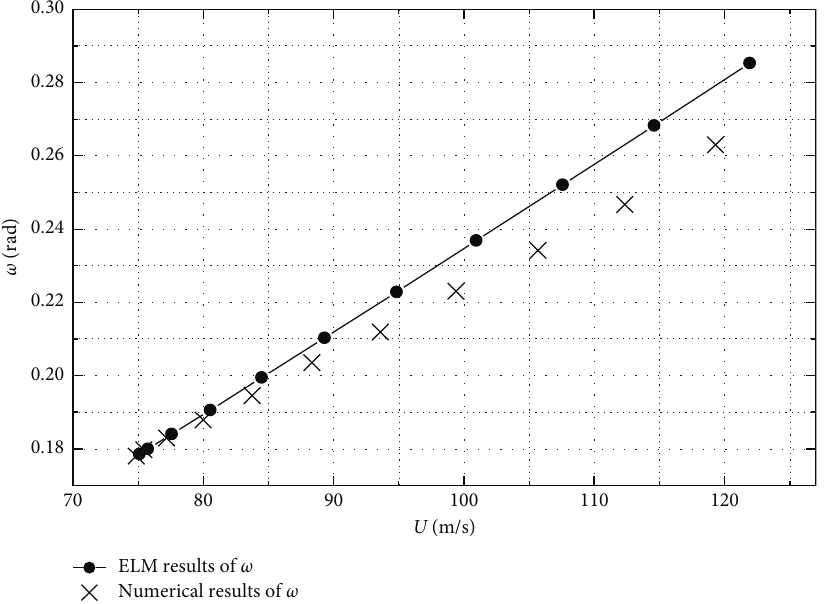
Figure 6: Curve of wind speed and frequency of LCOs.